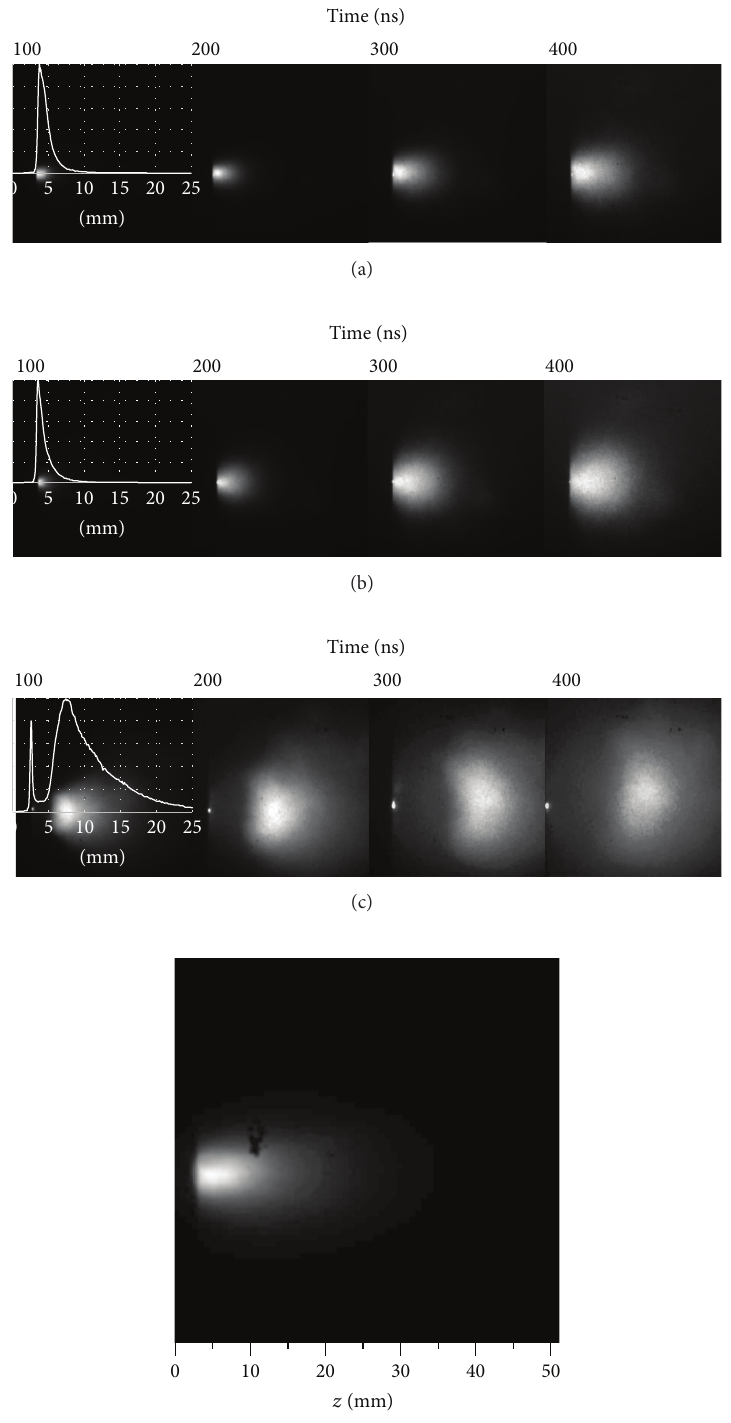
Figure 12: ICCD images of tungsten plasma for (a) tungsten 355 nm, (b) tungsten 1064 nm, (c) boron 355 nm, and (d) WB 2 /B 355 nm . Visible light, exposure time 20 ns, and delay time 100, 200, 300, 400 ns, respectively (WB 2 /B after 400 ns). Solid line denotes the intensity distribution of plasma radiation on the axis of plasma 𝑟 = 0